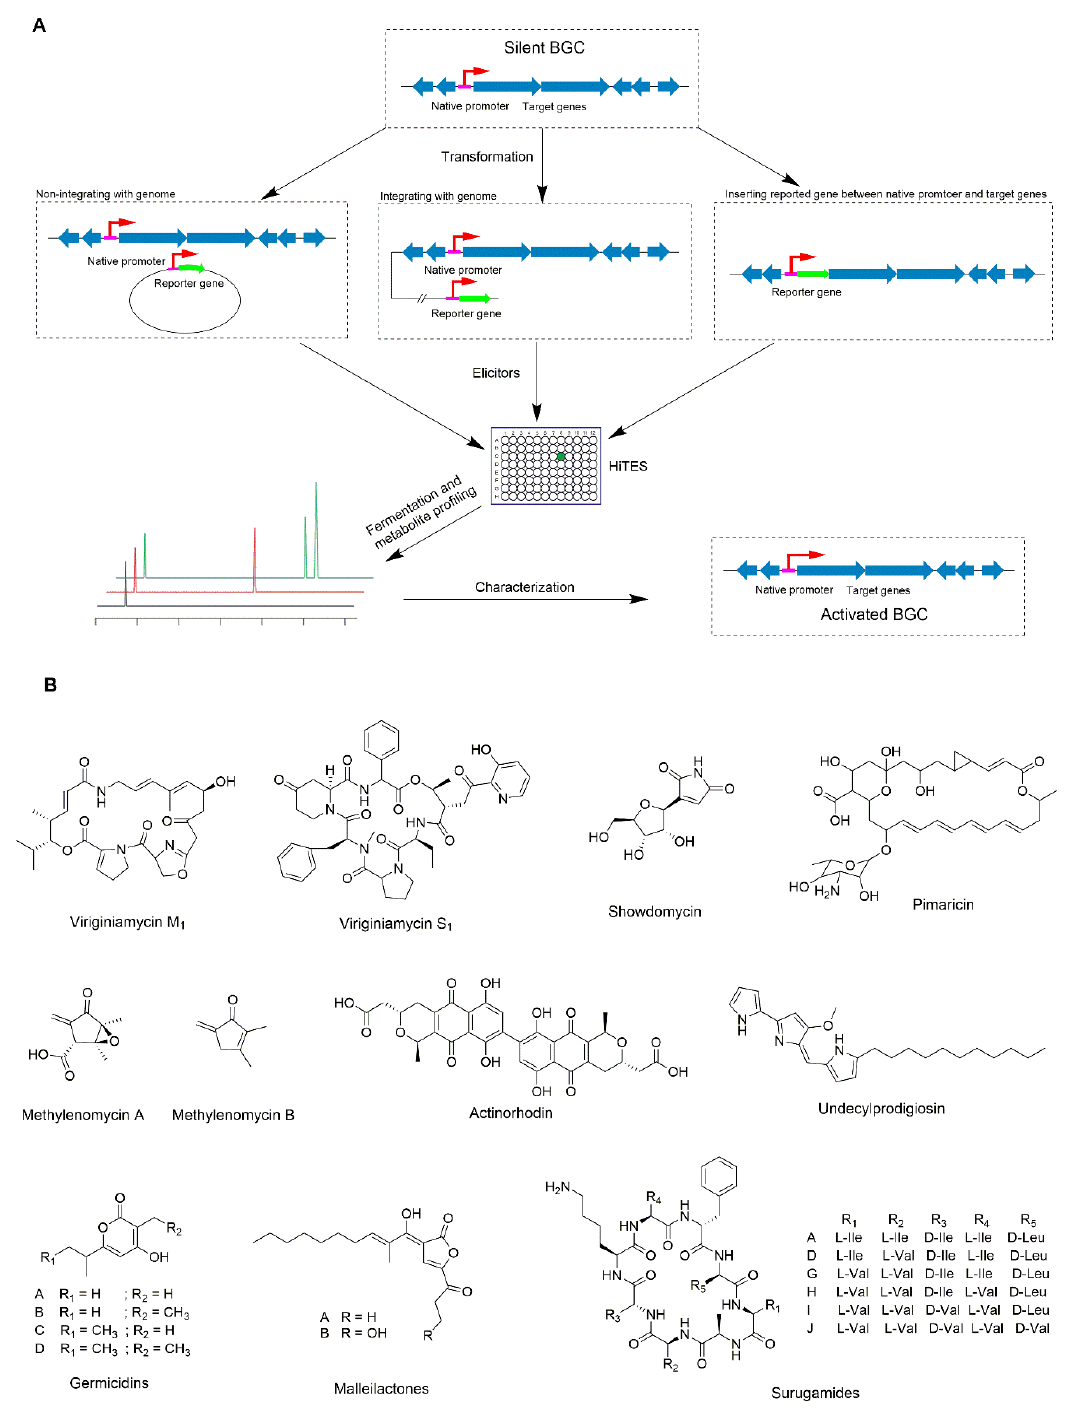
Figure 1. Overview of High-Throughput Elicitor Screens (HiTES) combined reporter-guided screening approach using rational elicitor. A . Overview of HiTES combined reporter-guided screening approach using rational elicitor. The red arrows represent the promoter. The green arrows represent the reporter gene. B . Structure of compounds are activated by HiTES combined reporter-guided screening approach using rational elicitor.